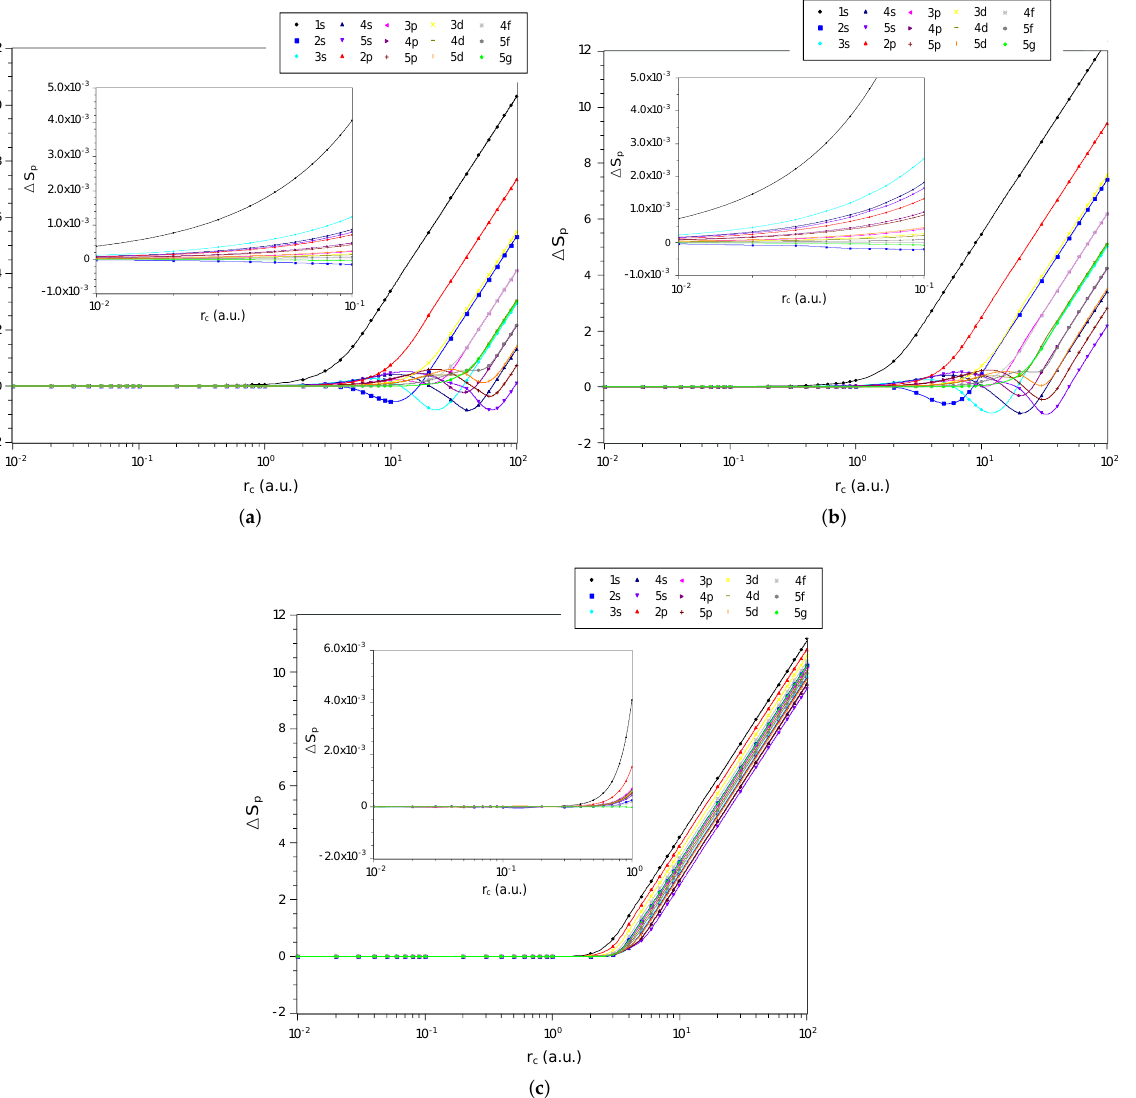
Figure 2. Values of ∆ S p in different quantum states as a function of r c on a logarithmic scale for the ( a ) hydrogen confined, ( b ) ion-sphere, and ( c ) confined harmonic oscillator. Now, we analyze the difference, ∆ S t , between the values of entropy sum of each of the three systems and that of the particle confined in a cage, calculated by Equation (23), as function of confinement radius, r c . Specifically, ∆ S t for states with 1 ≤ n ≤ 5 and 0 ≤ l ≤ 4 are shown in Figure 3a–c for the confined hydrogen atom, the confined ion in a strongly coupled plasma and the spherically confined harmonic oscillator, respectively. Again we observe that all ∆ S t , for the three systems, tend to zero when the confinement radius decreases. This indicates that in a rigorous confinement regime the entropy sum tends to behave like that of a particle confined in a spherical cage. However, a different behavior of ∆ S t can be noticed when compared with ∆ S r and ∆ S p for intermediate and large values of r c . In the entropy sum case, the values of converge asymptotically to constant values. For the ∆ S r and ∆ S p quantities, the values increase (positively or negatively) due to the behavior of S r and S p for an electron confined in a spherical cage (see discussion at the end of this